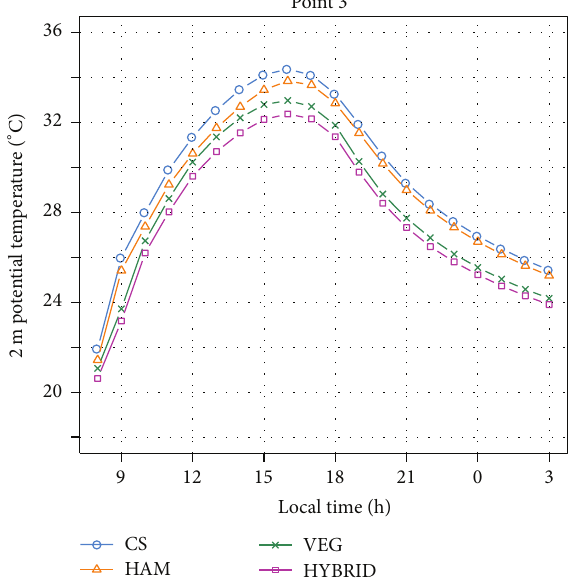
Figure 17: 2m potential temperature time series at Point